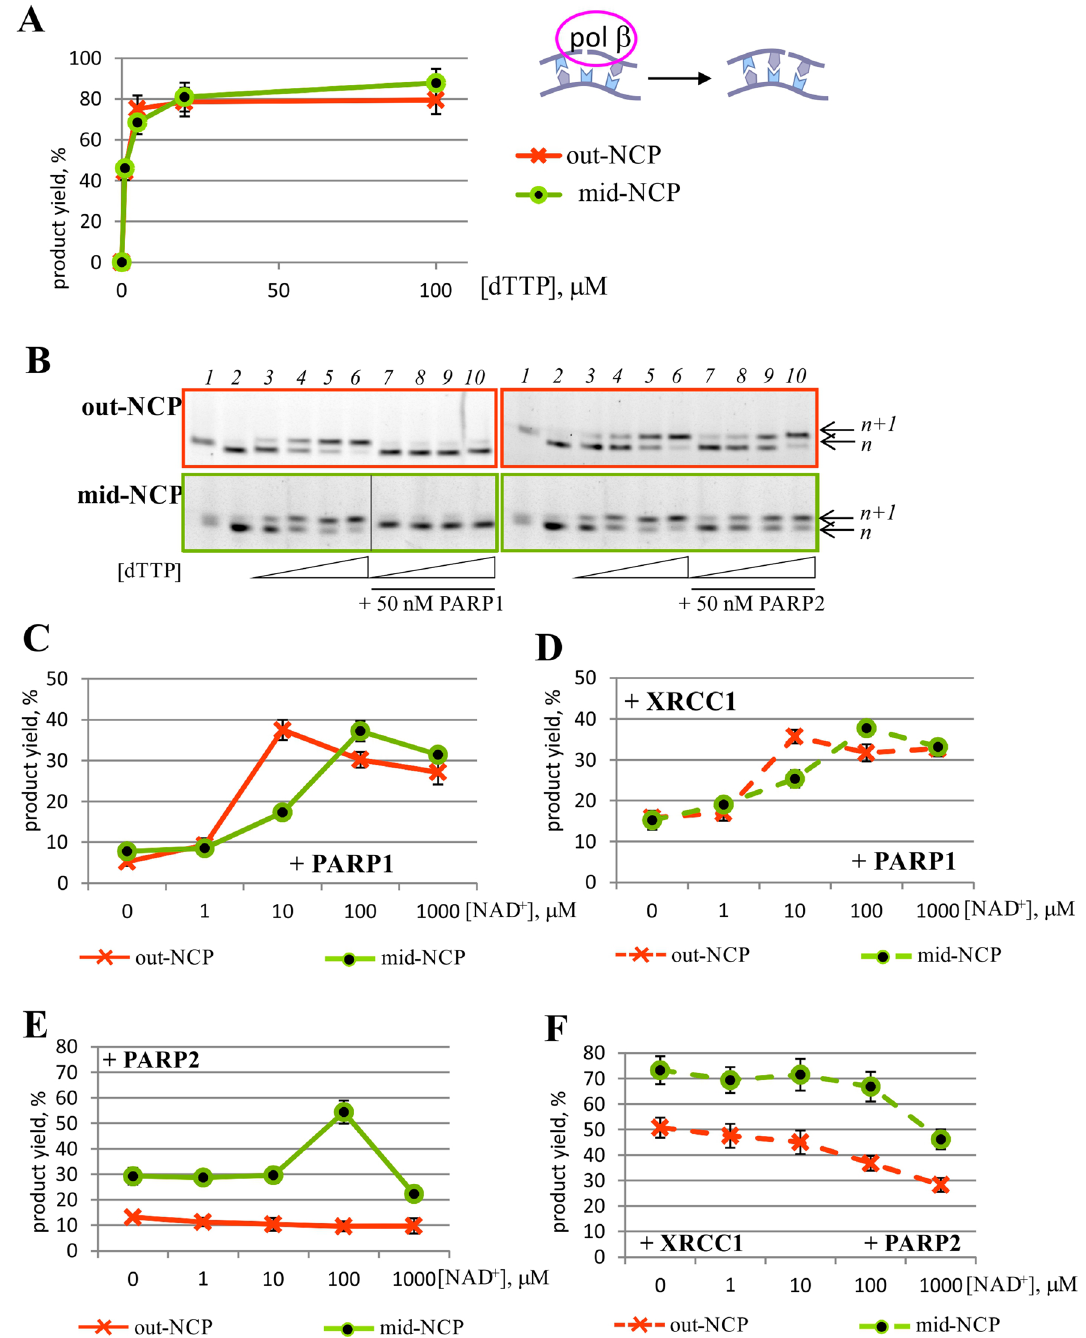
Figure 4. The activity of Polβ towards gap-NCP substrates by itself ( A , B ) and during PARylation catalysed by PARP1 ( C , D ) or PARP2 ( E , F ) in the absence ( A – C , E ) or presence of XRCC1 ( D , F ). The graphs in panels ( C – F ) represent the data obtained at 10 μM dTTP and 50 nM PARP1 or PARP2. The data are presented as an average of at least three independent experiments and are shown as the mean ± SD. ( B ) The reaction products of dTMP incorporation by Polβ (lanes 3–6) in the presence of PARP1 (left part) or PARP2 (right part, lanes 7–10) when outward- (upper panel) or midward-oriented (lower panel) 5 ′ -FAM–labelled gap-NCP was employed. Lane 1: substrate AP-NCP, lane 2: substrate gap-NCP. In all cases, Polβ concentrations of 2.5 and 50 nM were chosen as the reaction conditions for substrates out-NCP and mid-NCP, respectively. The reaction products were separated on a 15% denaturing polyacrylamide